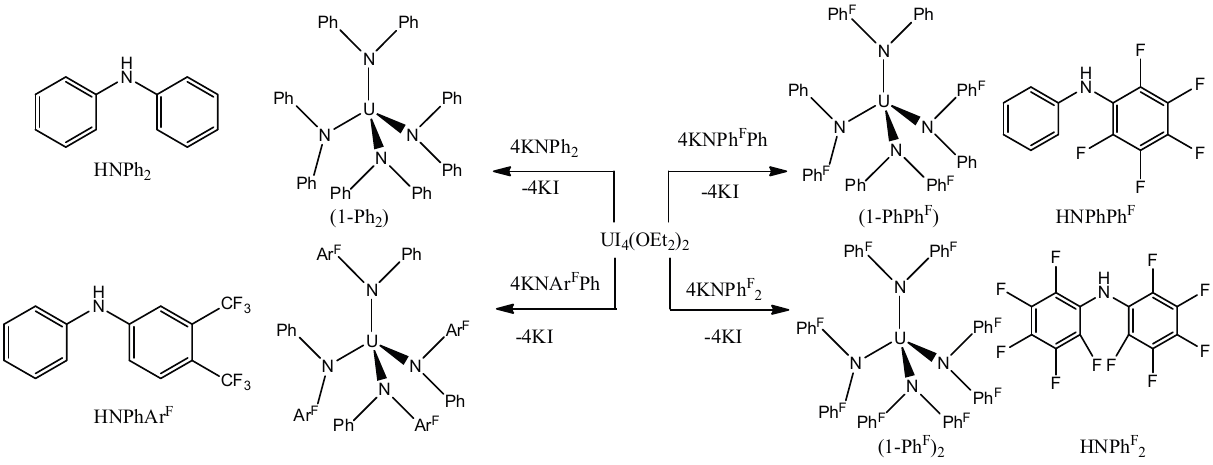
BNMe BH ) ] from neutron diffraction data. 3 2 3 4